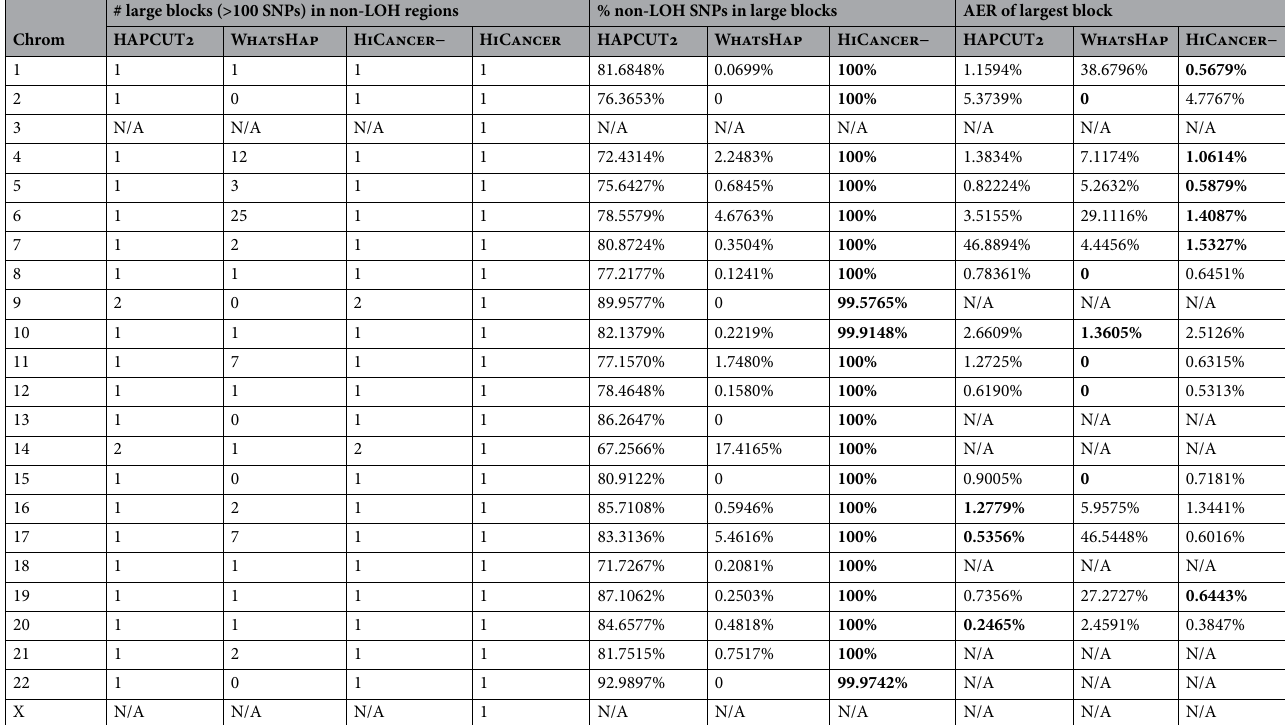
Table 1. Comparing the phasing performance of HiCancer with HAPCUT2 and WhatsHap on K562 genome. “Chrom” is the abbreviation of “Chromosome”; “HiCancer−” represents the output of HiCancer without doing the step of completing. Numbers in boldface highlight the best completeness and correctness. For the chromosomes whose whole or almost whole chromosomes are LOH regions, ‘N/A’ is used for some statistics cannot be